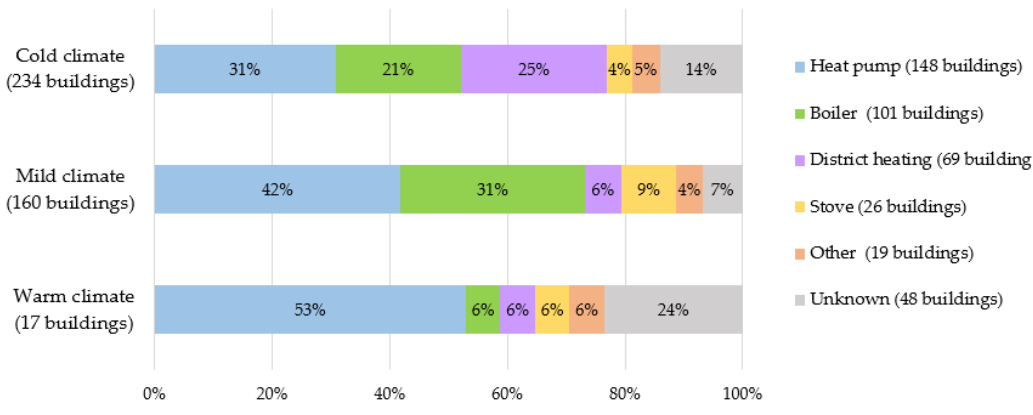
Figure 16. Share of heating systems according to climatic zones.